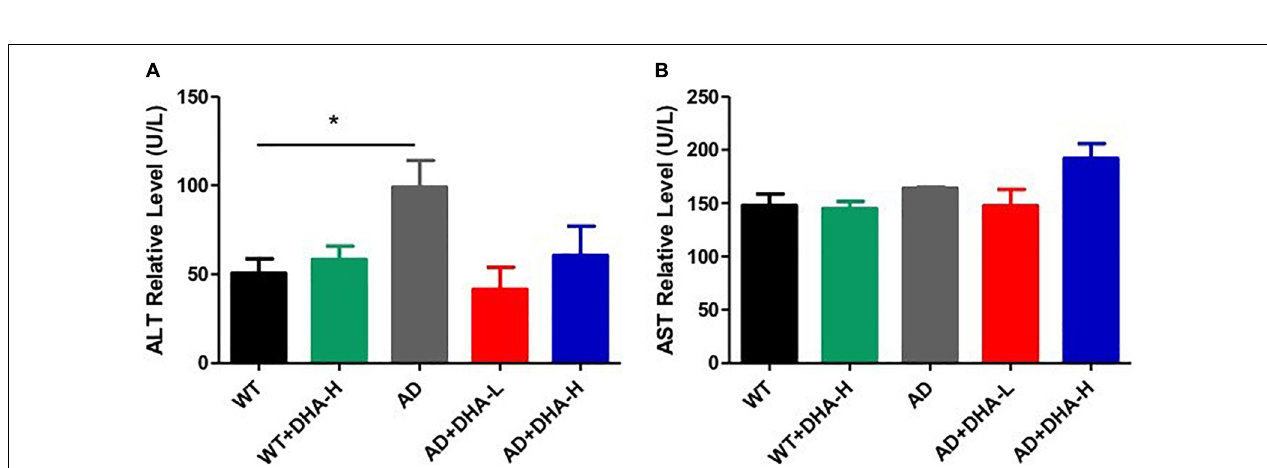
FIGURE 7 | Effects of DHA treatment on liver - indicators in 2 × Tg AD mice. (A) Alanine aminotransferase; (B) aspartate transferase (* p < 0.05). The student’s t test was used for statistical analyses. Error bars represent mean ± S.E.M. ( n = 6).